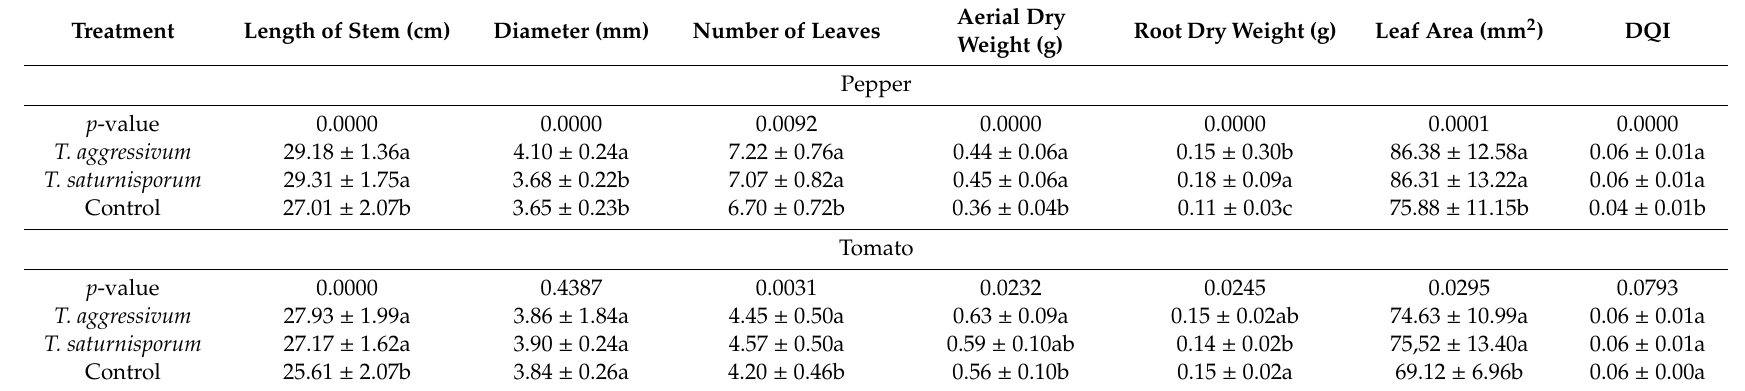
Di ff erent letters indicate significant di ff erences according to the one-way ANOVA test ( p = 0.05). DQI: Dickson Quality